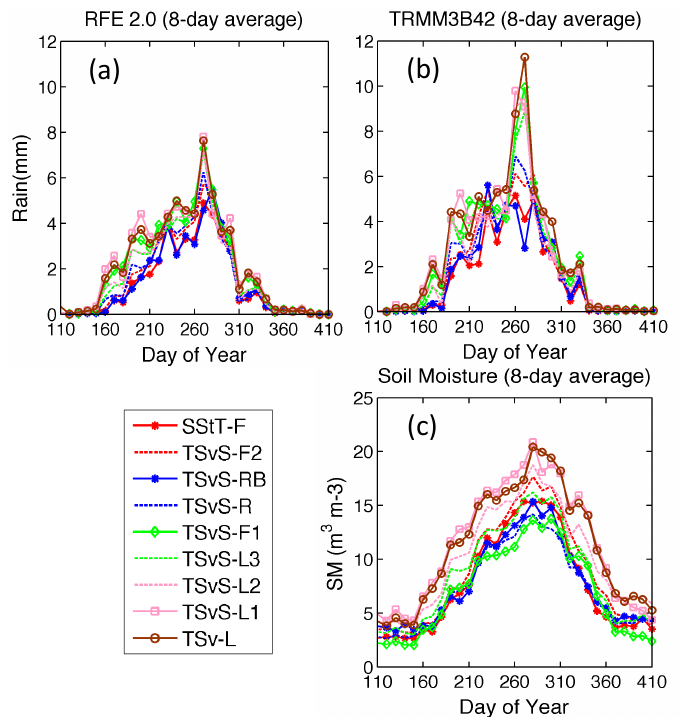
Figure 4. Average rainfall over eight-day intervals from ( a ) RFE and ( b ) TRMM; and ( c ) soil moisture for each Vegetation-Soil Zone (VSZ) averaged over the 2000–2010 decade (see Table 3 for legend items).